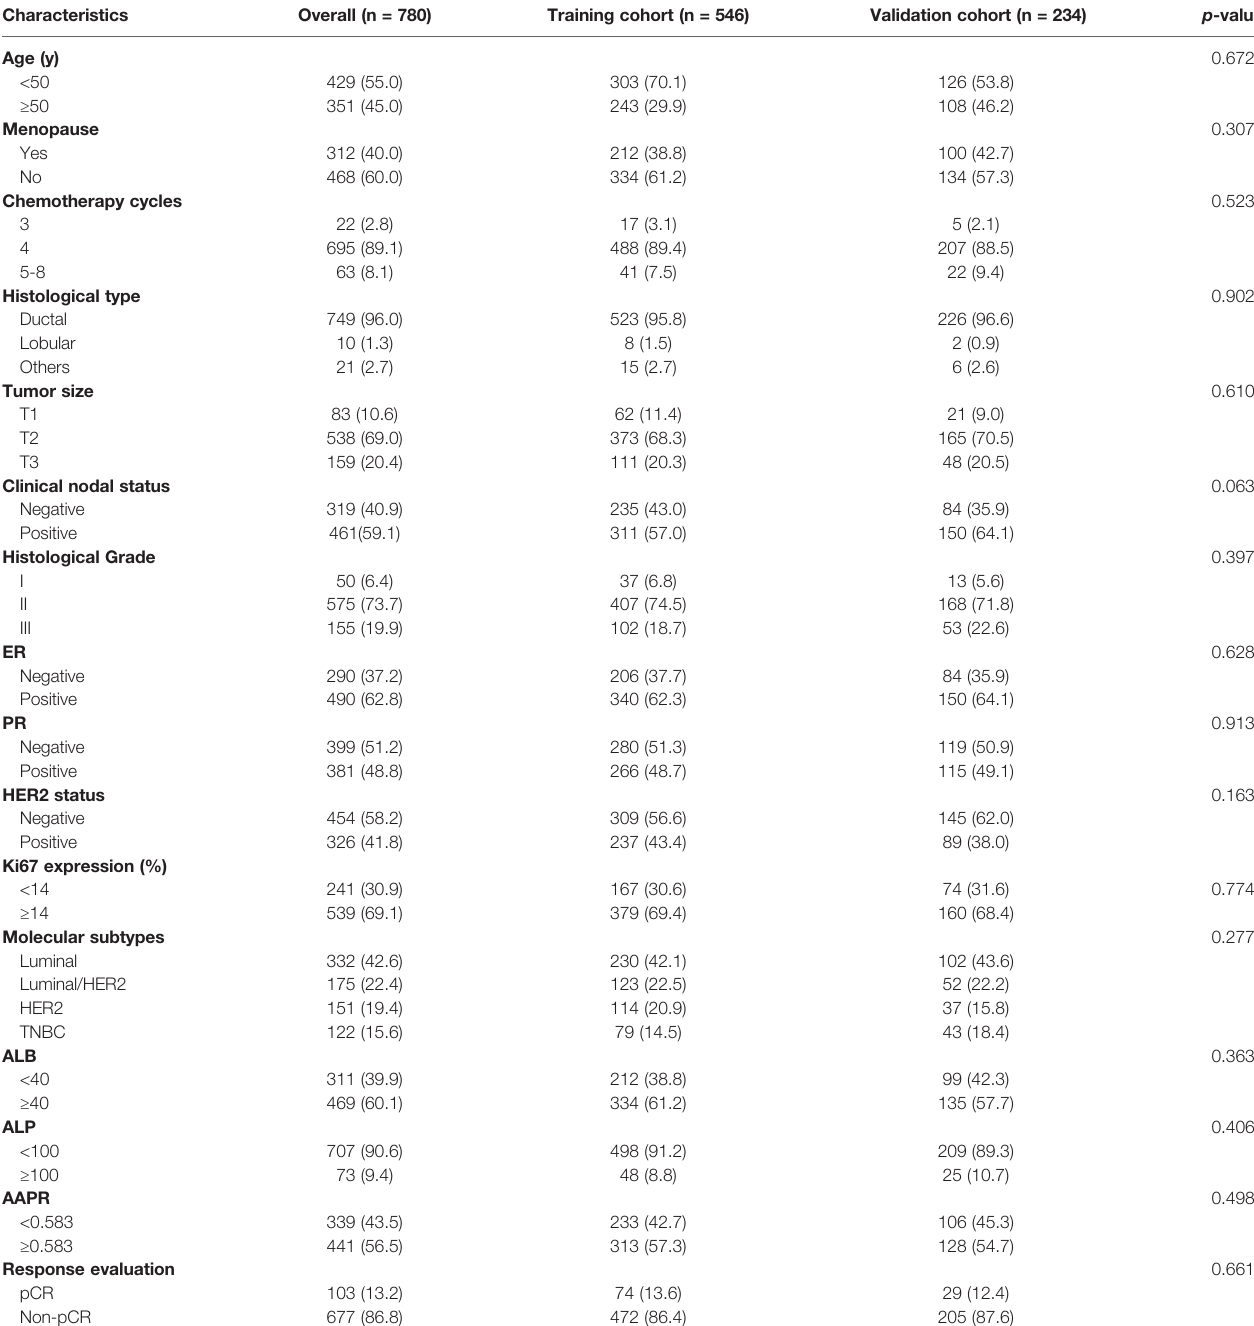
TABLE 1 | Clinicopathological characteristics in the training, validation and overall cohorts.